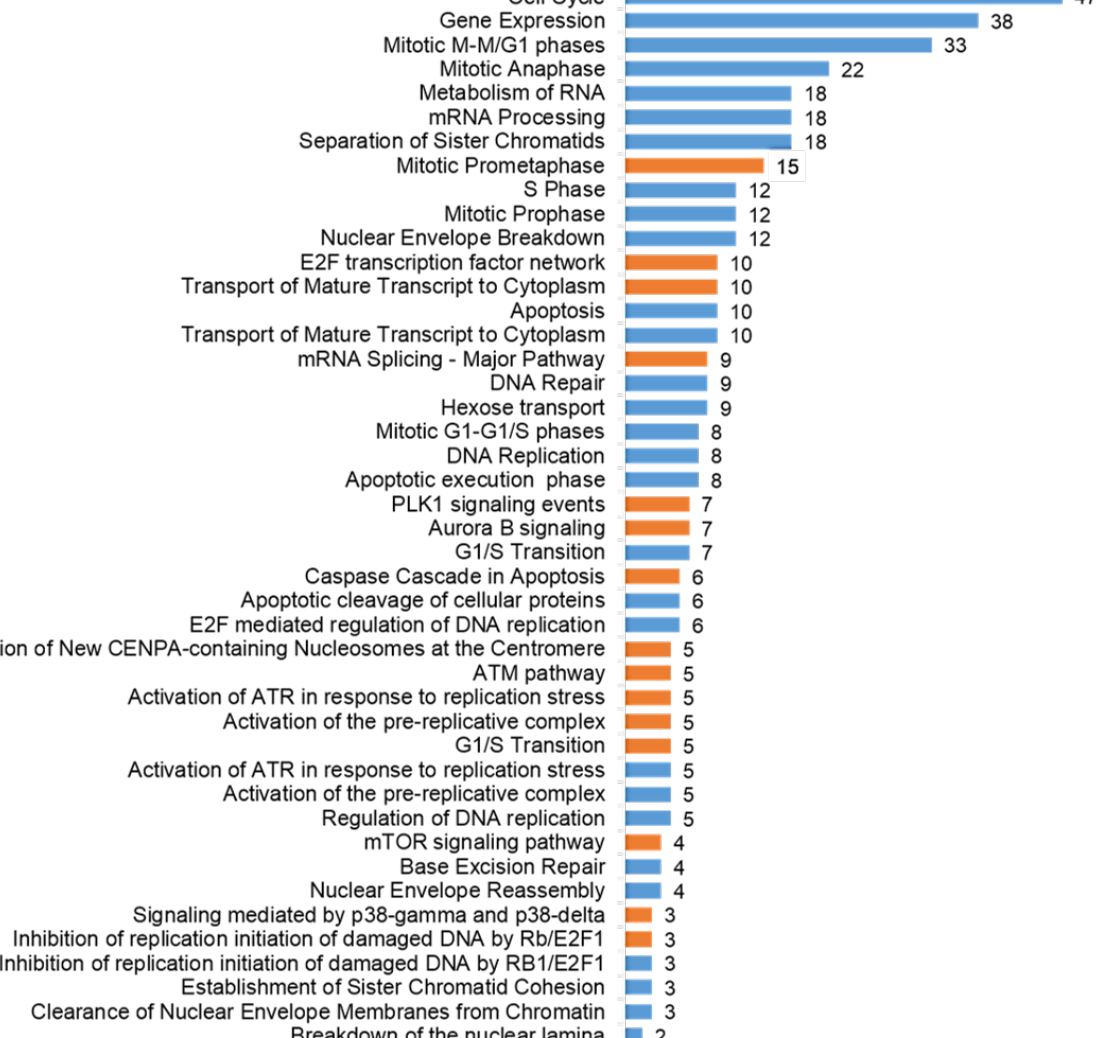
Figure 3. Selected results of Reactome pathways (blue bars) and Pathway Interaction Database (PID) pathways (orange bars) over-representation analysis (FDR < 0.01): x -axis shows the number of proteins involved in particular pathways that were differentially phosphorylated in our